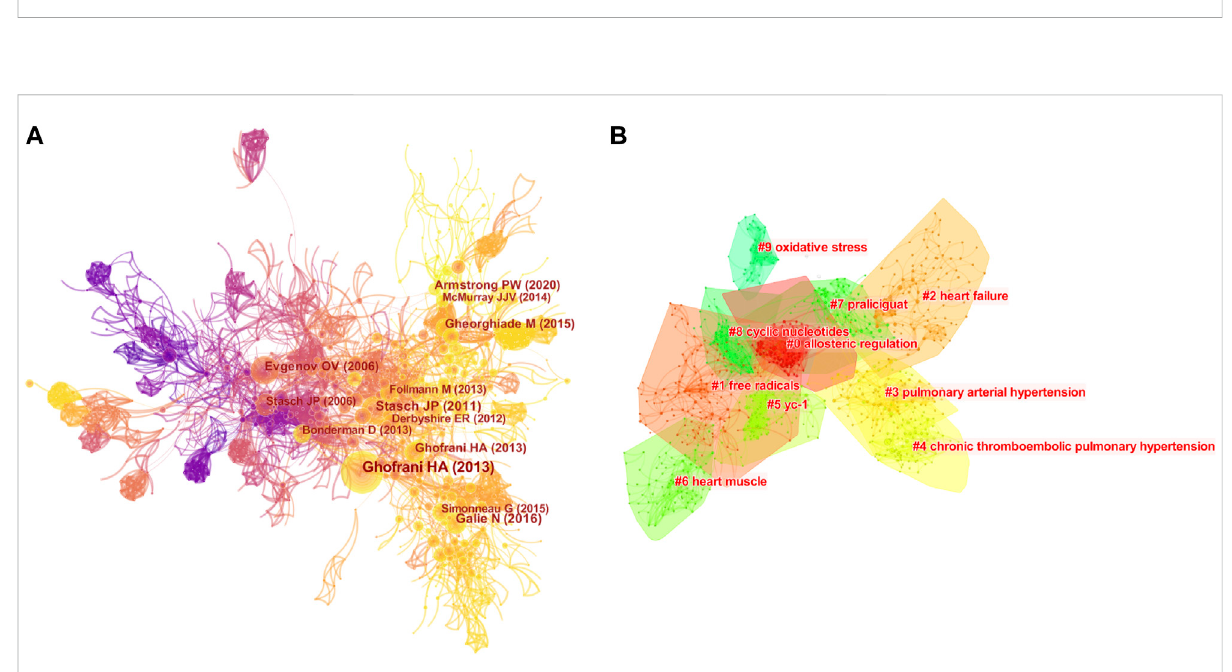
FIGURE 4 Mapanalysisofco-citedreferencestosGCstimulatorsincardiovascularresearch. (A) Networkmapofco-citedreferences. (B) Networkmapof co-cited reference